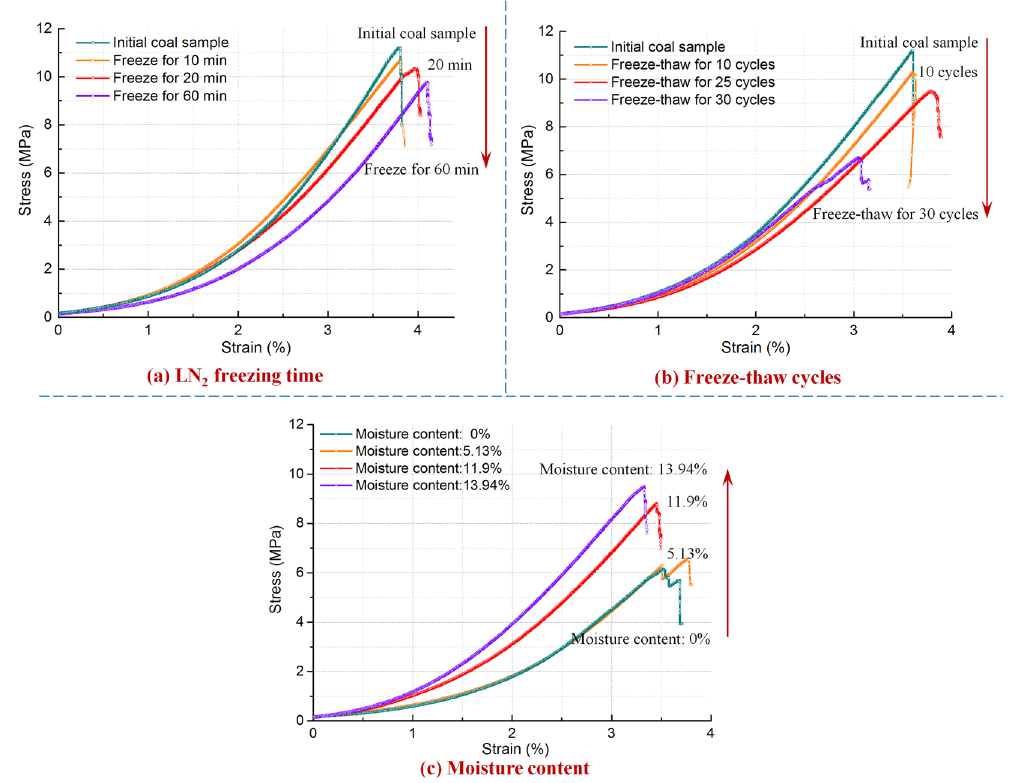
Figure 1. Uniaxial stress-strain curves for coal samples subjected to three different freeze-thaw variables. The stress-strain curves for the three variables shown in: ( a ) LN 2 freezing time; ( b ) freeze-thaw cycles; ( c ) coal’ moisture